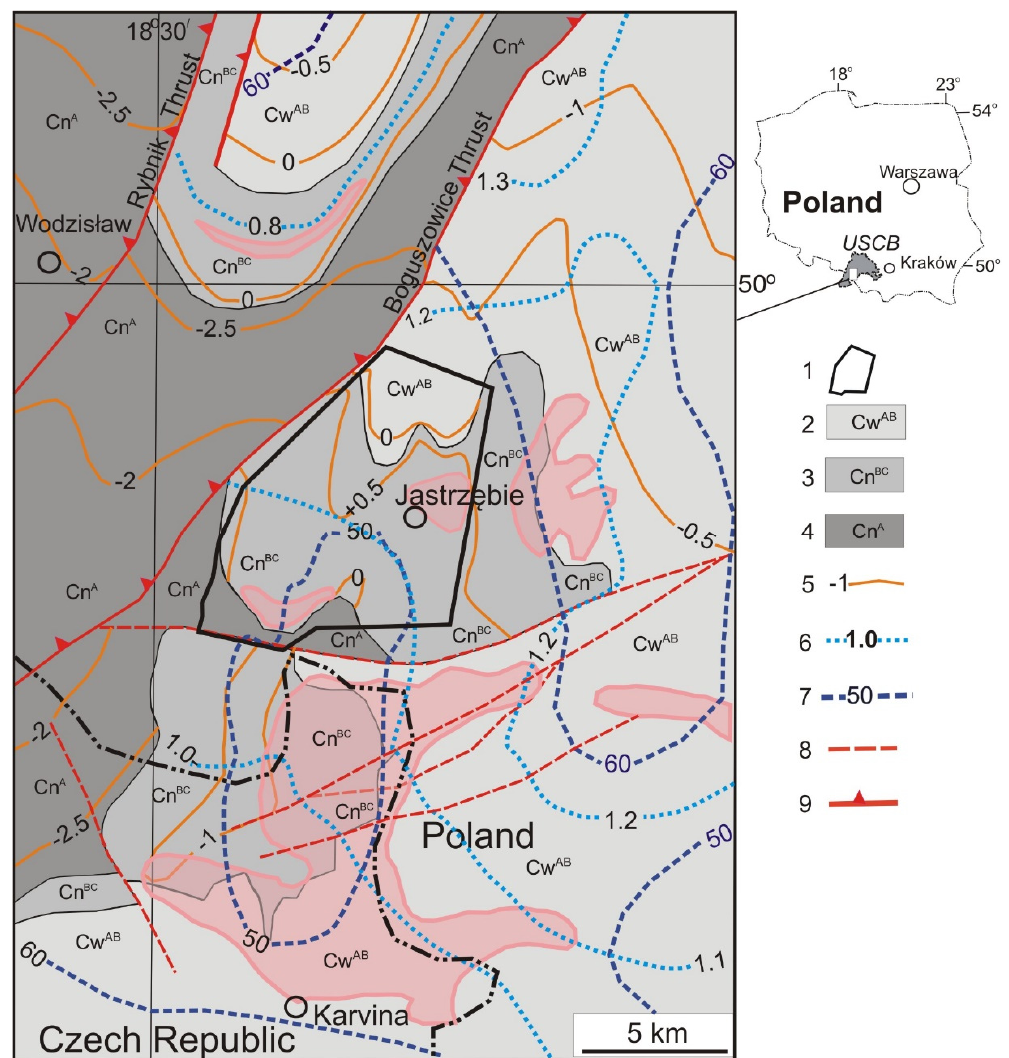
Figure 1. Subsurface structural map of the Carboniferous coal-bearing Paralic, Upper Silesian Sandstone and Mudstone Series in the western part of the Upper Silesian Coal Basin (USCB) (after [9,10]; simplified). Areas with vanishing coal seams and associated altered gangue rocks at the top of the Carboniferous units are shown in pink. 1: Jas-Mos mining area, a part of the Jastrz ę bie-Bzie Coal Mine; 2: Mudstone Series, Westphalian AB (Cw AB ), with bottom isolines (coal seam 405); 3: Upper Silesian Sandstone Series, Namurian BC (Cn BC ), with bottom isolines (coal seam 510); 4: Paralic Series, Namurian A (Cn A ), with bottom isolines; 5: bottom isolines in km a.s.l.; 6: isolines of average random vitrinite reflectance R r (%); 7: isolines of average vitrinite content (%); 8: fault; 9: thrust.